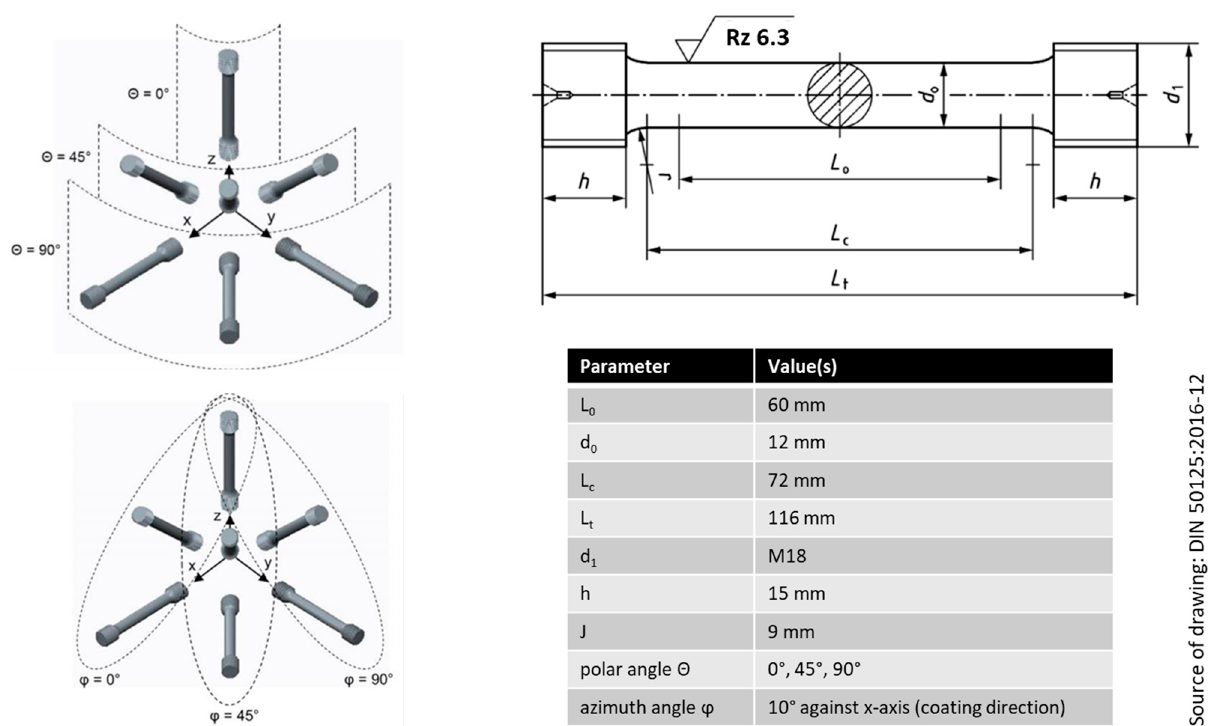
Figure 2. Samples’ dimensions according to DIN 50125:2016-12 and explanation of the build orientation [44]. Note that in the sketches to the left, the z -axis is the vertical direction, while the x -axis is the re-coating direction in the present experiment and the plane of the build platform is spanned by the x - and y -axes together. Θ is the polar and φ is the azimuth angle.